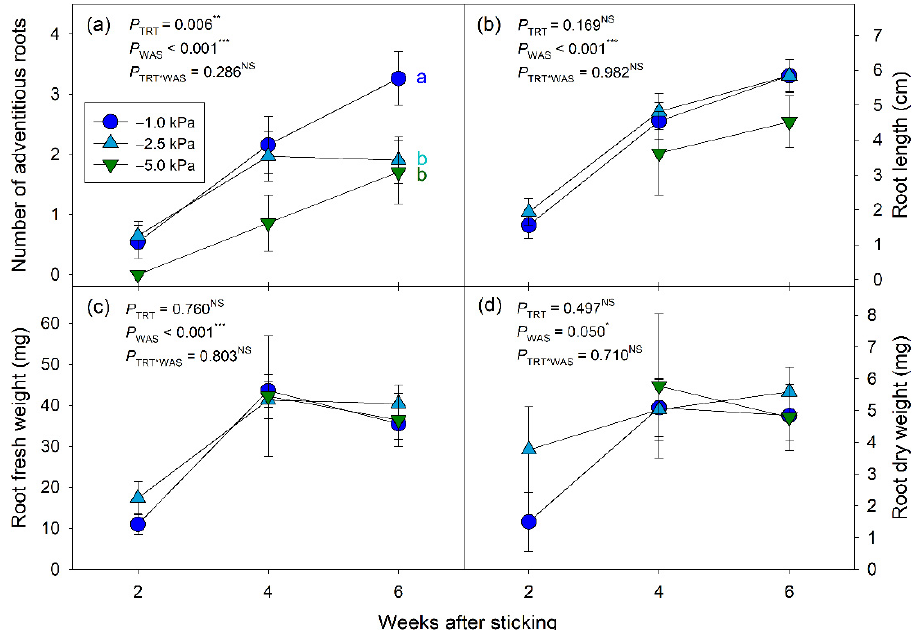
Figure 4. Root properties of propagated English lavender ( Lavandula angustifolia ) cuttings at three irrigation thresholds ( − 1.0, − 2.5, and − 5.0 kPa). ( a ) The number of adventitious roots, ( b ) root length, ( c ) root fresh weight, and ( d ) root dry weight at two, four, and six weeks after sticking (WAS). Points marked with the same letter are not significantly different according to Duncan’s multiple range test at α ≤ 0.05 (at each week of observation). * , ** , *** , or NS indicates significance at p ≤ 0.05, 0.01, 0.001, or not significant, respectively. Error bars indicate standard errors.